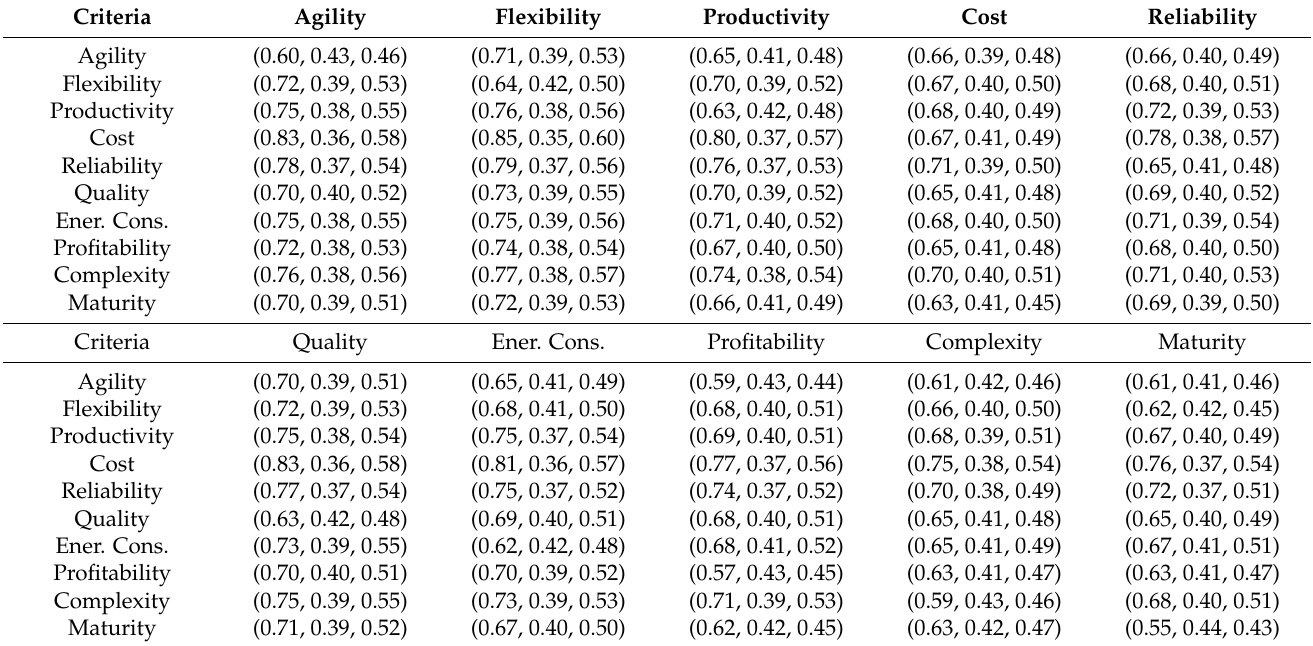
Table A3. The SF total influence matrix.